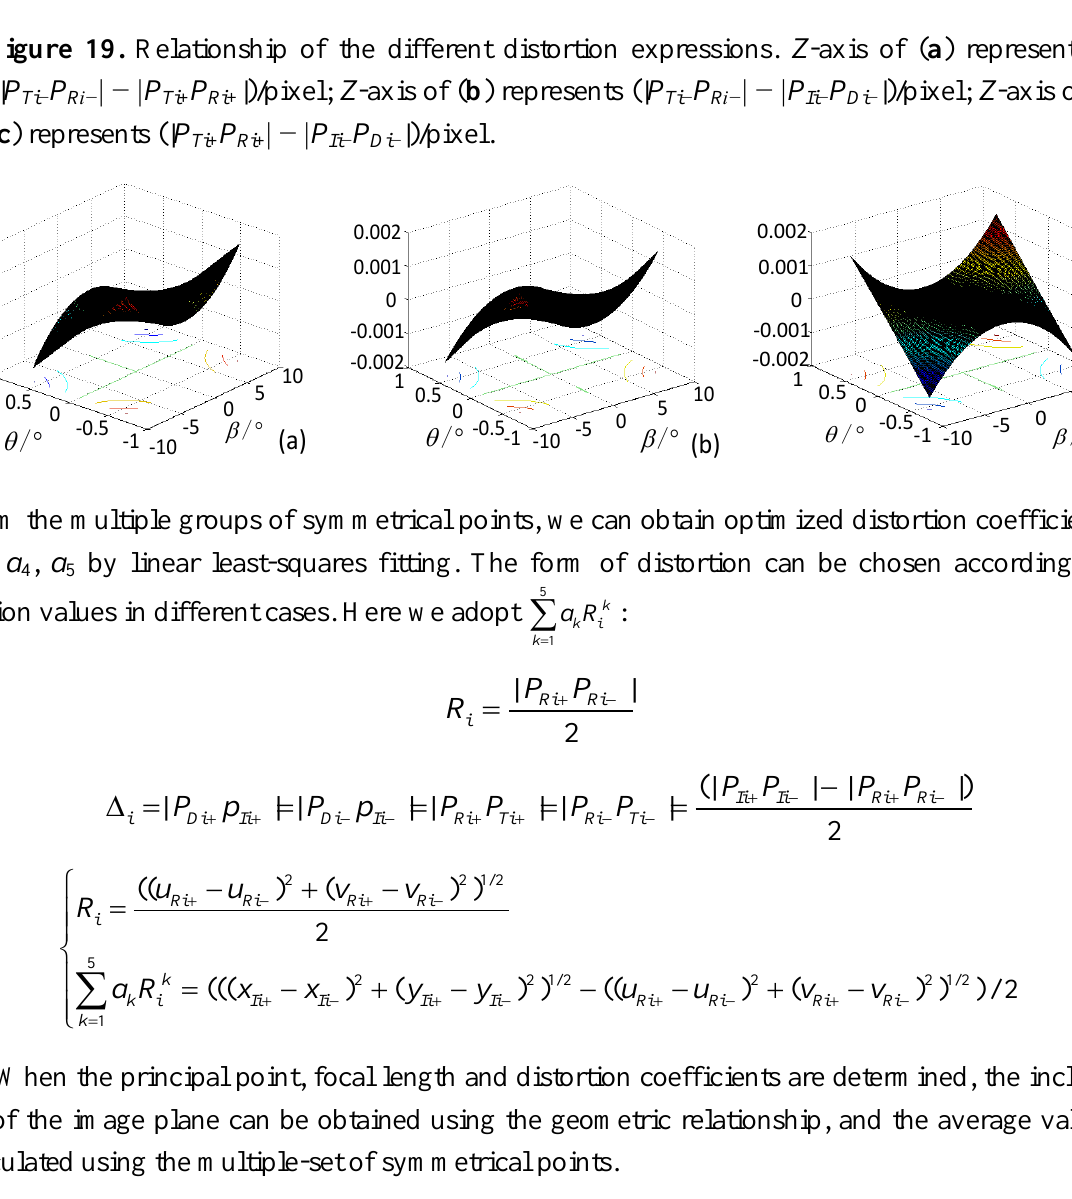
P | − | P P |)/pixel; Z -axis of Ti − Ri− Ii − Di −